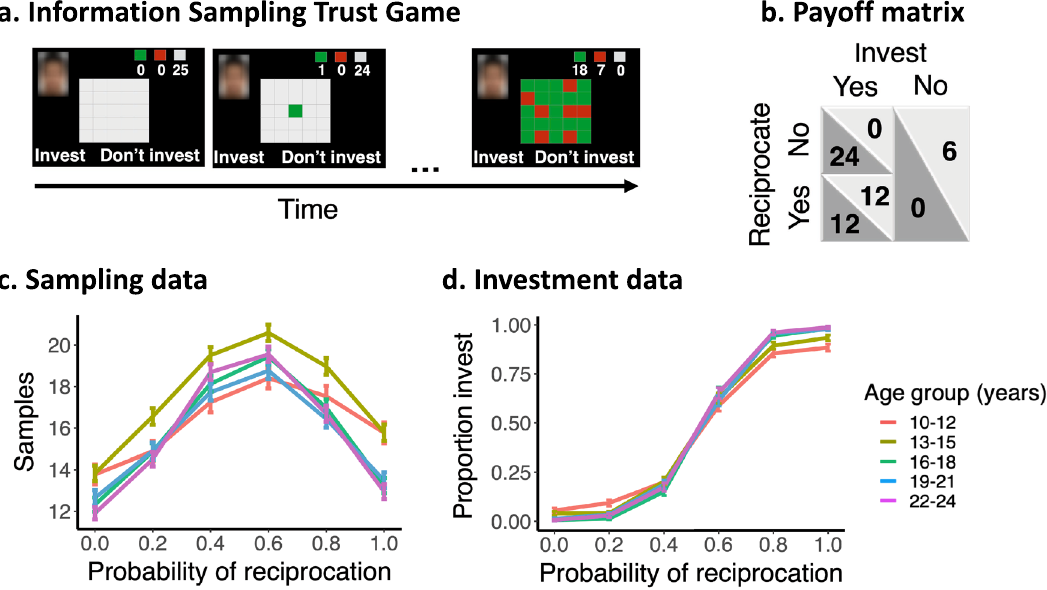
Figure 2. Information Sampling Trust Game and data. ( a ) Task trial sequence example and payoff matrix. On each trial there are 2 players: the investor and a trustee. The participants played in the investor role and could sample a trustee’s reciprocation history with other investors up to 25 times by turning tiles in a 5 by 5 grid. Green = reciprocated trust, red = betrayed trust, grey = not sampled. Investment outcomes were not shown during the task. Six reciprocation probability conditions ( r = 0.0, 0.2, 0.4, 0.6, 0.8, 1.0) generated the outcomes in the grid. It was clarified in the instructions that they were playing with someone their own age, that the location of the tile was not informative, that each trial would be played with a new unknown trustee, and that the ratio green to red tiles may thus vary between trials. ( b ) Payoff matrix. Participants were told that if they invested, the trustee received the 6 tokens, which would be multiplied by 4 (24 tokens) and subsequently the trustee would decide to either reciprocate by splitting the 24 tokens 50–50, or defect and keep all 24 tokens to themselves. Participants also had the option of not investing by keeping the initial endowment. ( c ) The number of samples (mean and standard error of the mean (s.e.m.)) as a function of reciprocation probability per age group (years). Age groups were created for visualization purposes only and analyses were conducted with age as continuous measure. ( d ) Proportion of investments as function of the generative reciprocation probability for each age